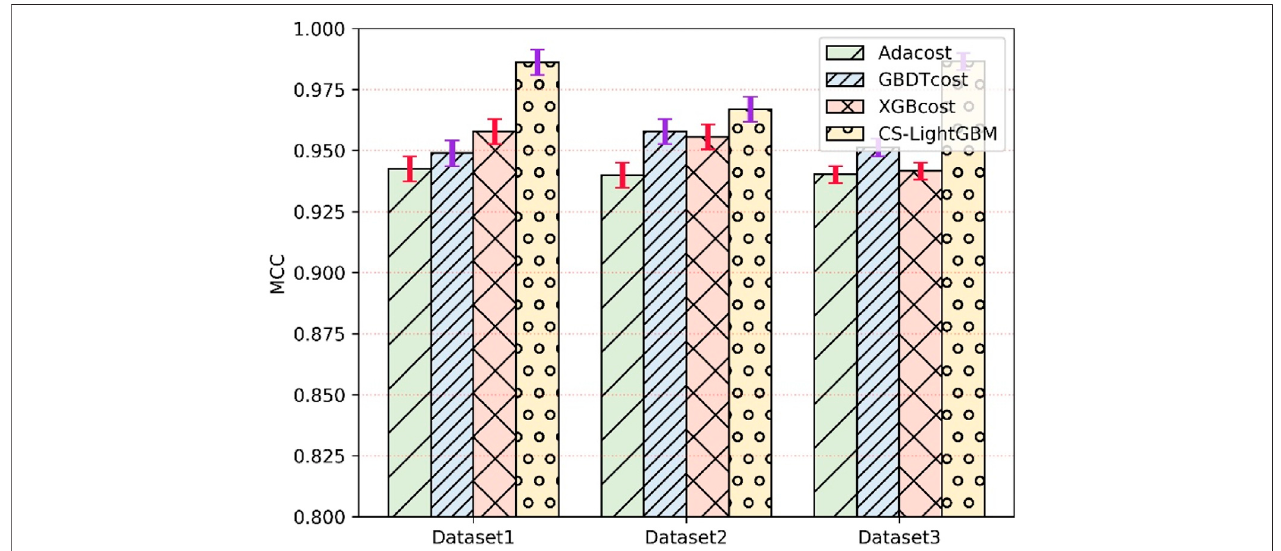
FIGURE 7 | Matthews correlation coef fi cient of four algorithms for fault detection of wind turbines